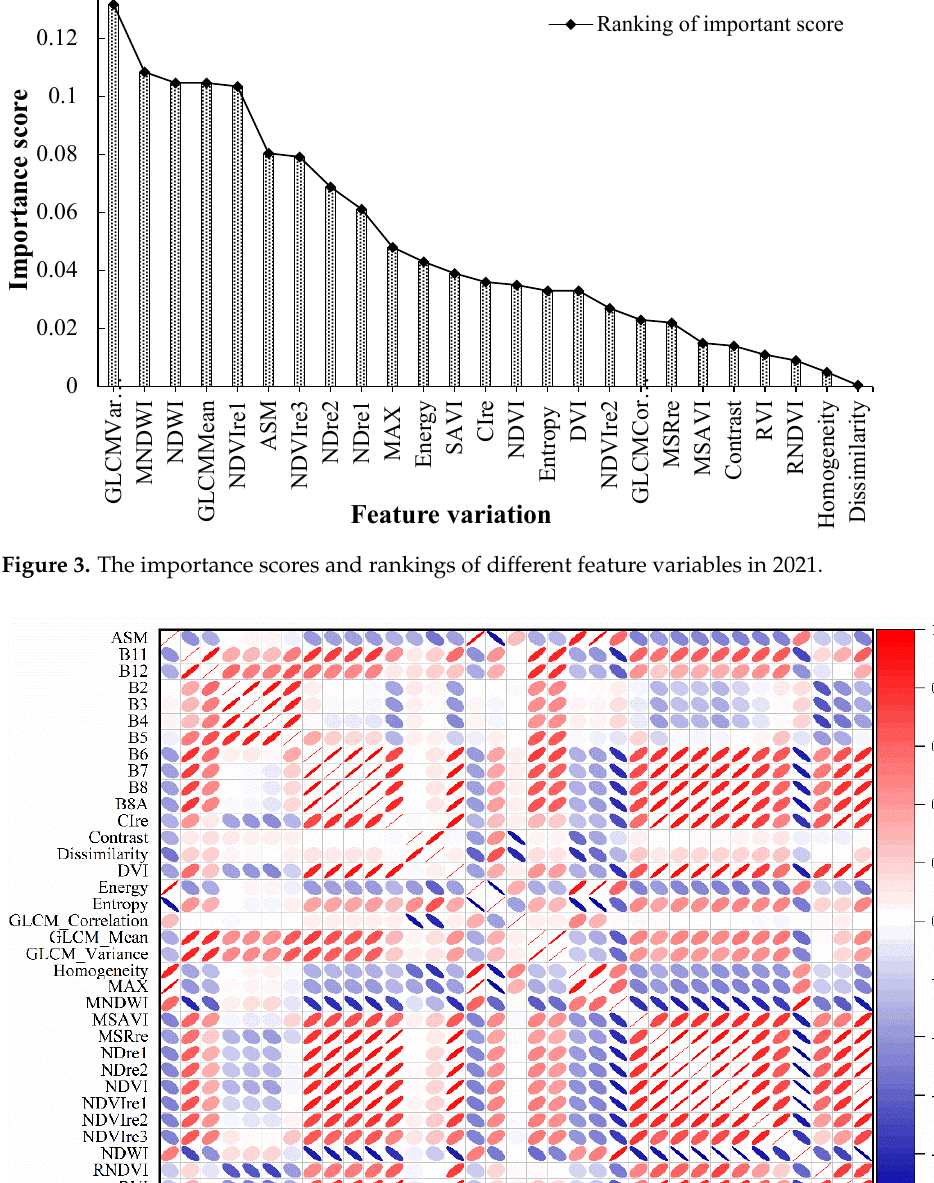
Table 3. Correlation levels of the correlation coefficient.